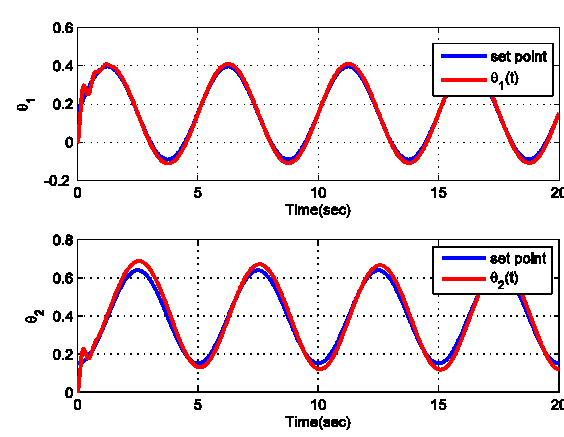
Fig. 6. MRSE tracking errors.